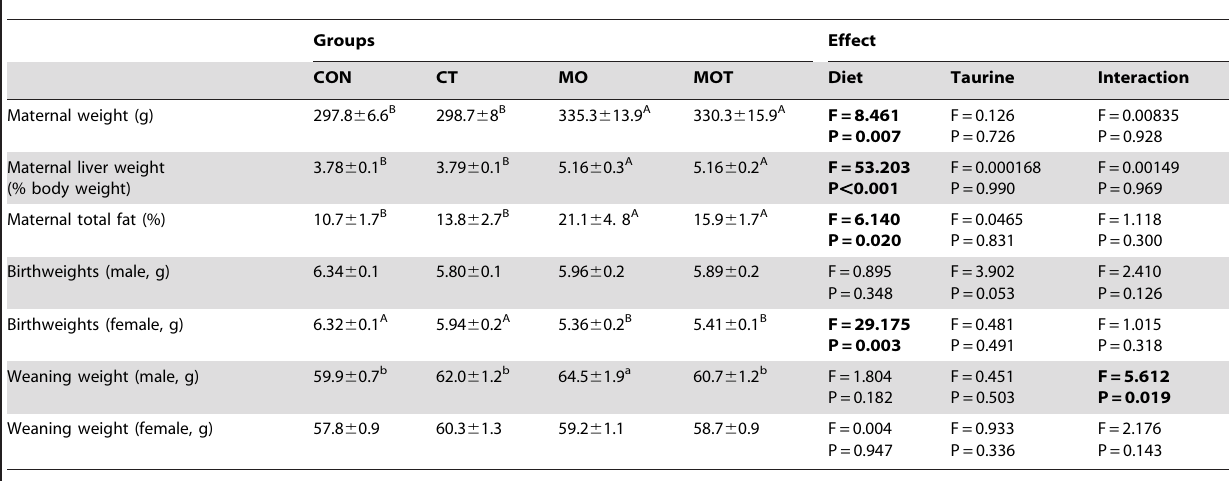
Table 1. Maternal, neonatal and weaning weight data.